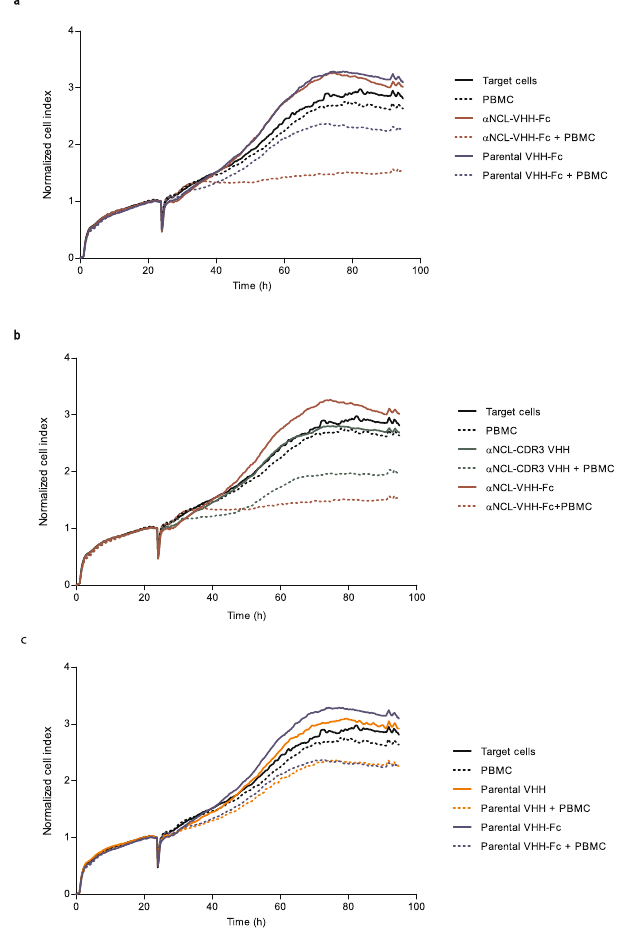
Figure 5. Cytotoxicity of anti-nucleolin VHHs in the presence of PBCMs, against MDA-MB-435S cells. MDA- MB-435S cells, previously cultured in a RTCA plate for 24 h, were incubated with protein, without (solid lines) or with human PBMCs (at a target cells/effector cells ratio of 1:10 or 1:5, dotted lines), for 72 h at 37 °C. Cell index, normalized to the beginning of the incubation, was measured every 15 min, using the xCELLigence system. ADCC effect of the anti-nucleolin VHH-Fc antibody (red) was further supported upon assessing its activity versus ( a ) 25 nM parental VHH-Fc (blue), ( b ) 50 nM α NCL-CDR3 VHH (green), ( c ) 25 nM parental VHH-Fc (blue) versus 50 nM parental VHH (orange). Data are from a representative experiment, performed in